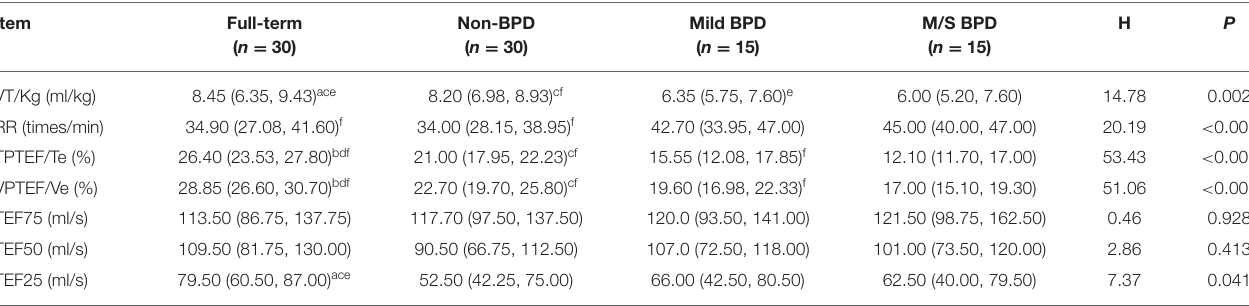
TABLE 4 | Lung function analysis in four